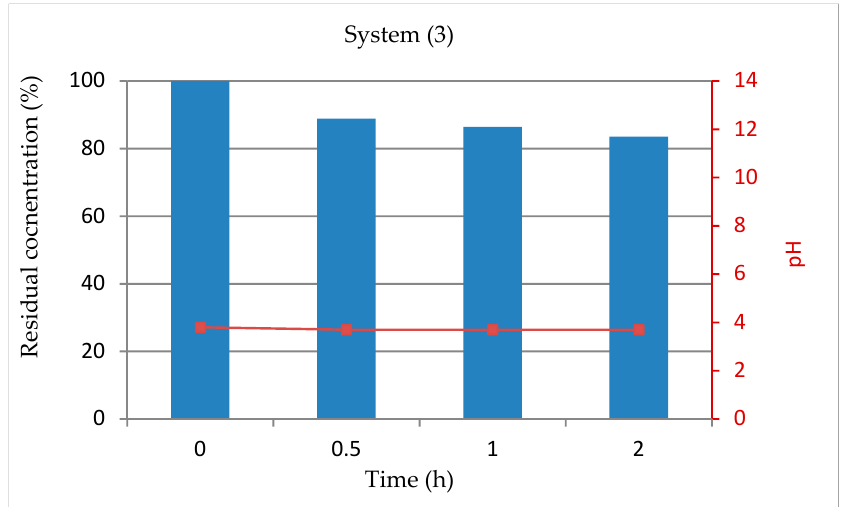
Figure 8. Residual concentration (%) and pH for System 3, as a function of the UV irradiation time exposure. Environments 2019 , 6 , x FOR PEER REVIEW